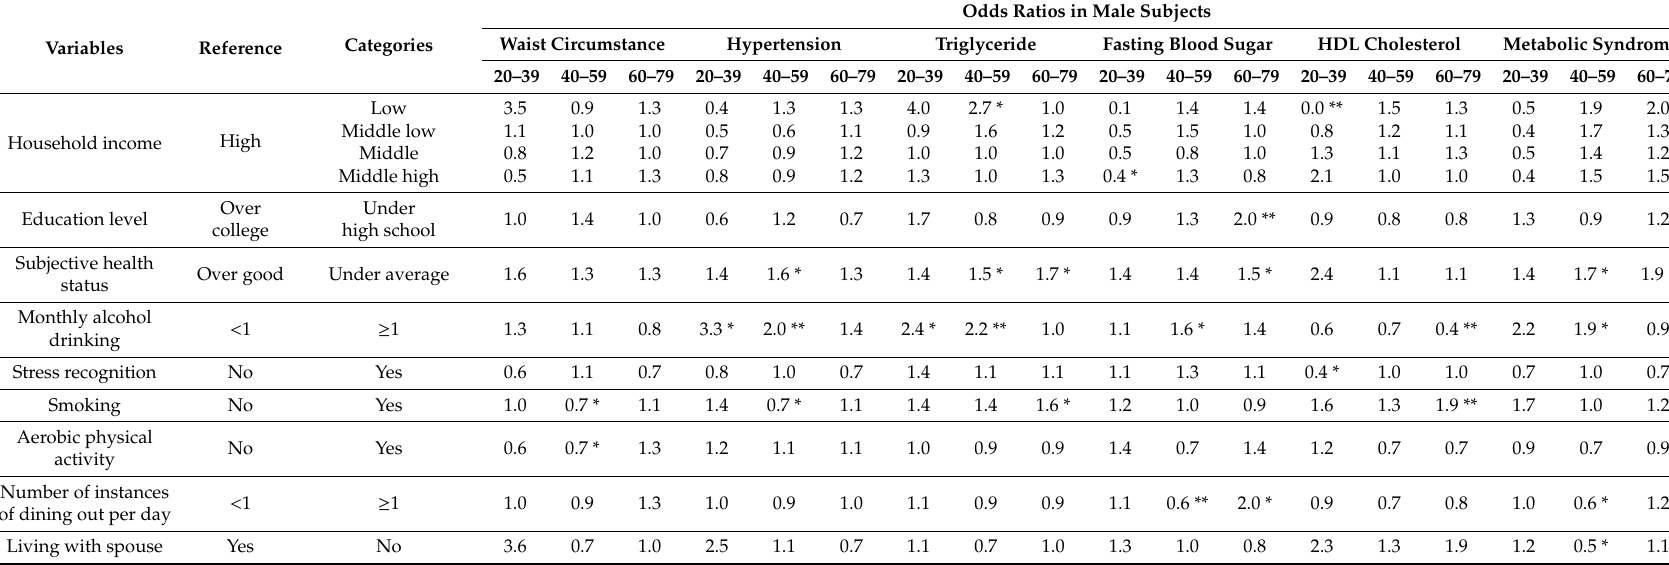
Table 3. Factors a ff ecting metabolic syndrome components in di ff erent male age